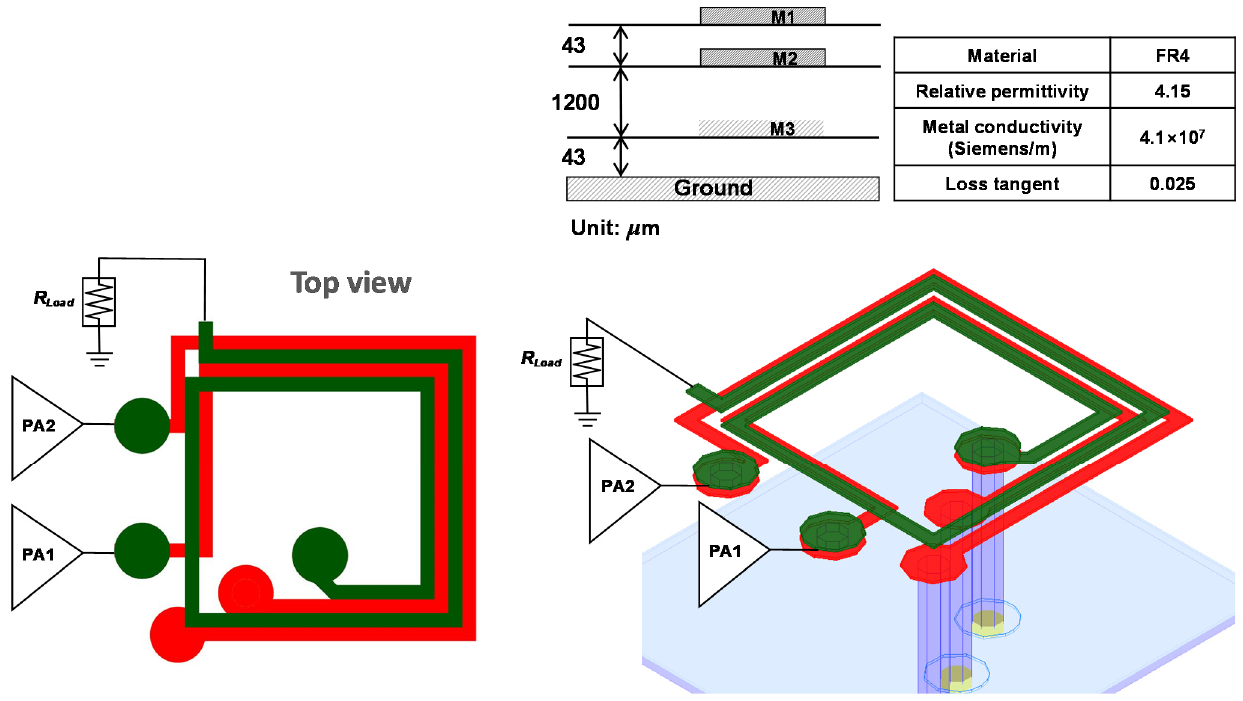
Figure 4. Layout of the PCT structure and layout information of the PCB. Two primary windings with a width of 100 μ m are designed using an M2 metal layer. The spacing between the two primary windings is 100 μ m. For the interconnection, PA1 and PA2 are connected to the primary windings through an M1–M2 via. The M1 top metal layer is used for the construction of the two-turn secondary winding with a width of 100 μ m. The electromagnetic (EM) simulated insertion losses in the HP and LP modes are plotted in Figure 5. The insertion loss, which is the inverse of the maximum available gain, has been used to evaluate the transformer efficiency [17]. The EM simulated insertion losses in the HP and LP modes are 0.27 dB and 0.45 dB, respectively.